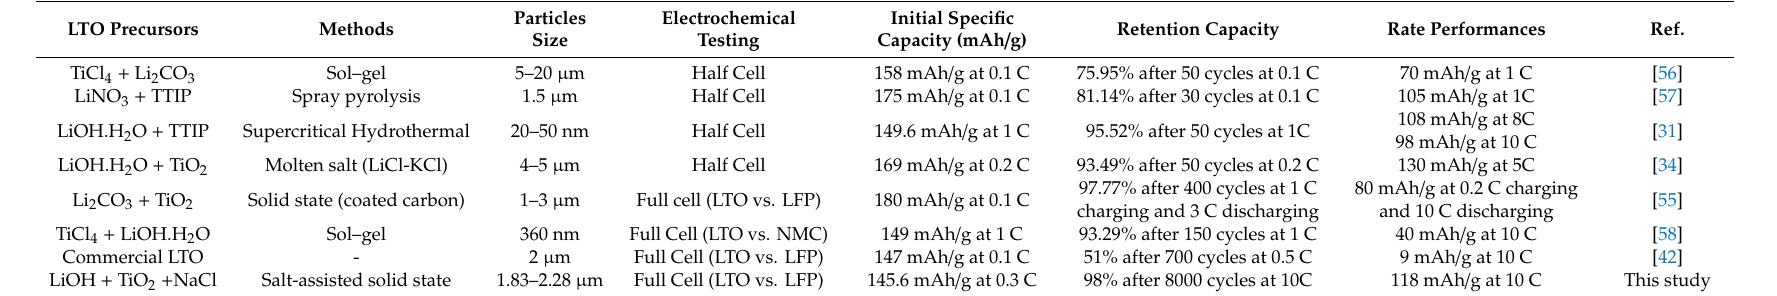
Table 3. Summary of LTO performances from previous